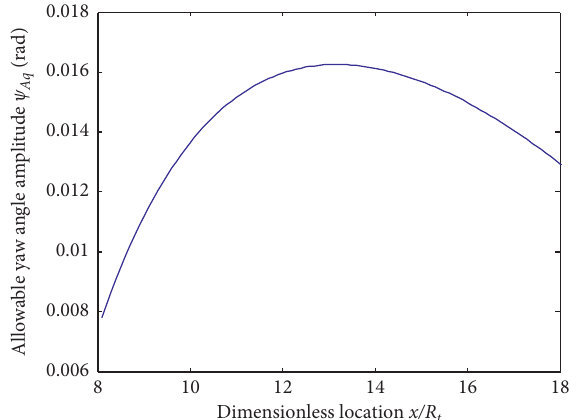
Figure 8: Relationship between allowable yaw angle amplitude and length of conical section.